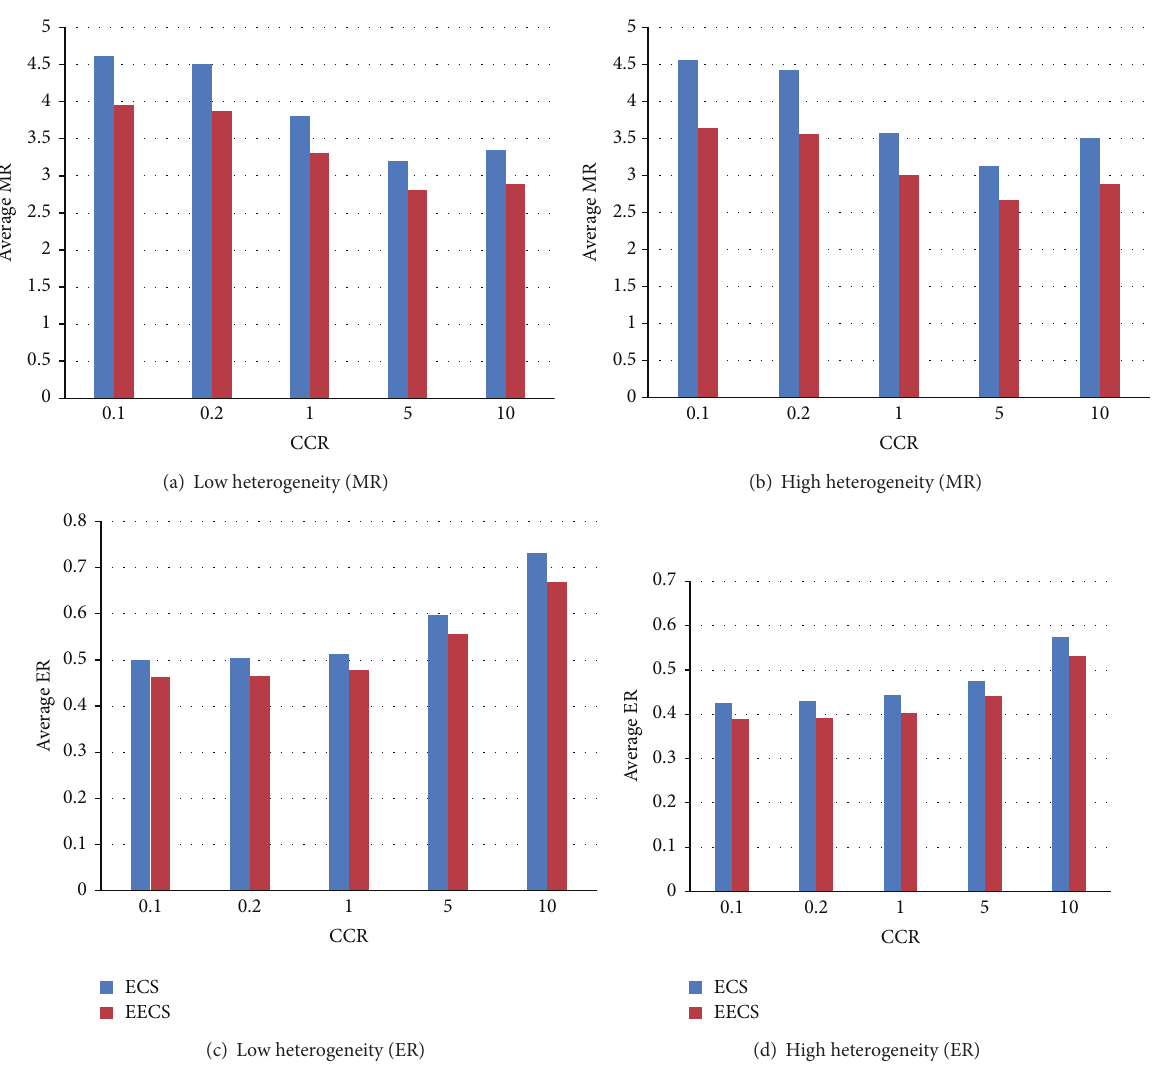
Figure 3: Laplace, 49 nodes (different heterogeneities of processors). Table 4: Task priorities of 𝐺 .